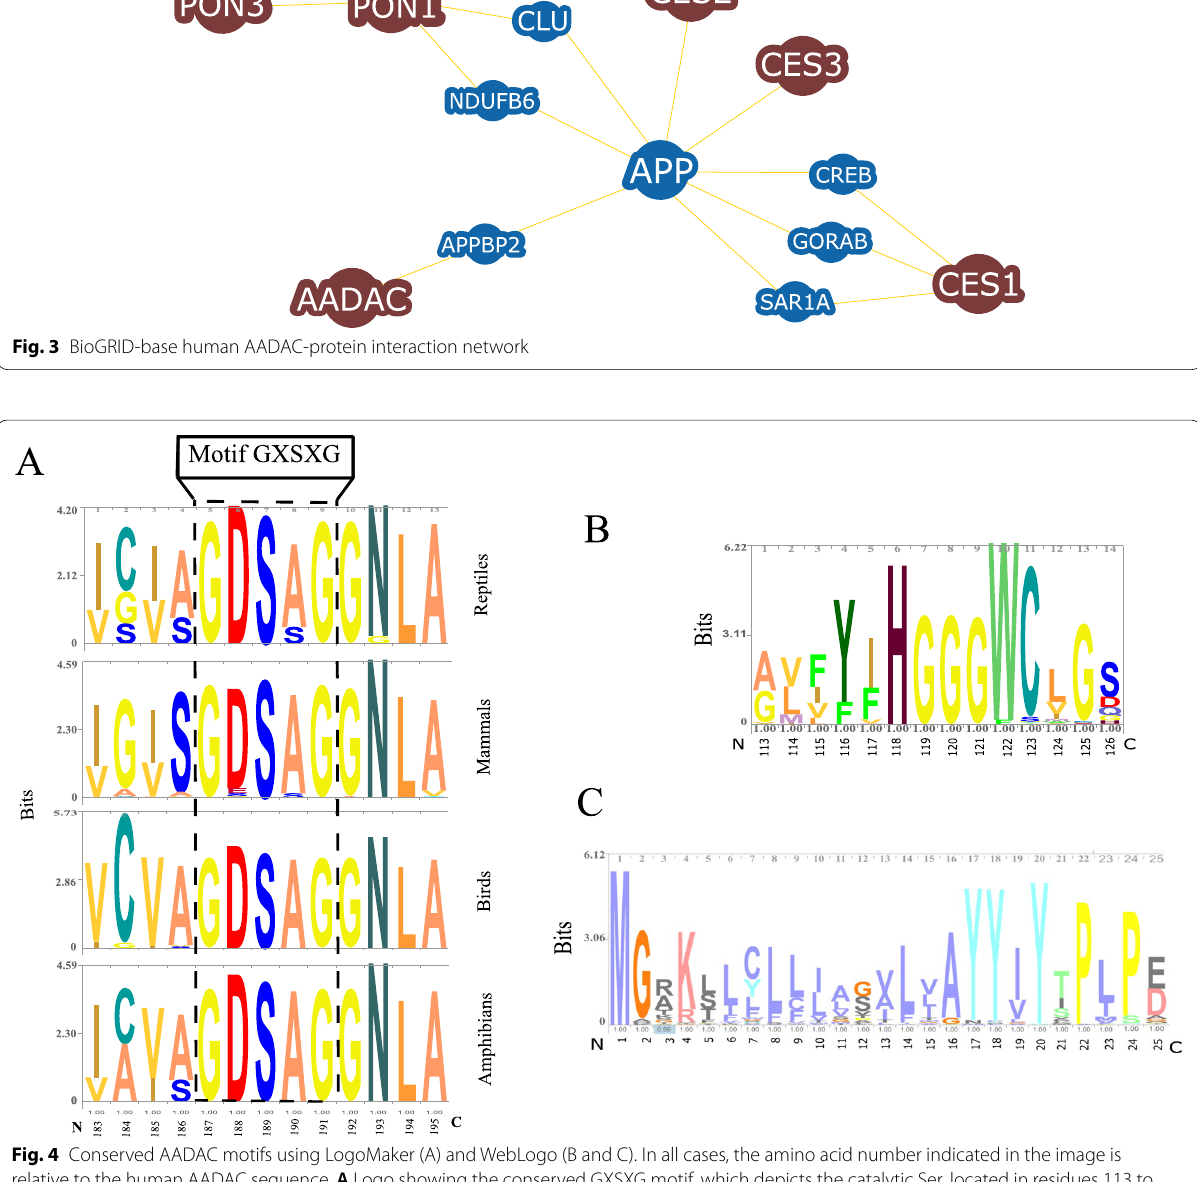
Fig. 4 Conserved AADAC motifs using LogoMaker (A) and WebLogo (B and C). In all cases, the amino acid number indicated in the image is relative to the human AADAC sequence. A Logo showing the conserved GXSXG motif, which depicts the catalytic Ser, located in residues 113 to 126. B Logo showing the conserved HGGG motif, located in residues 113 to 126. C Logo showing the conserved transmembrane region of AADAC orthologues, located in residues 1 to